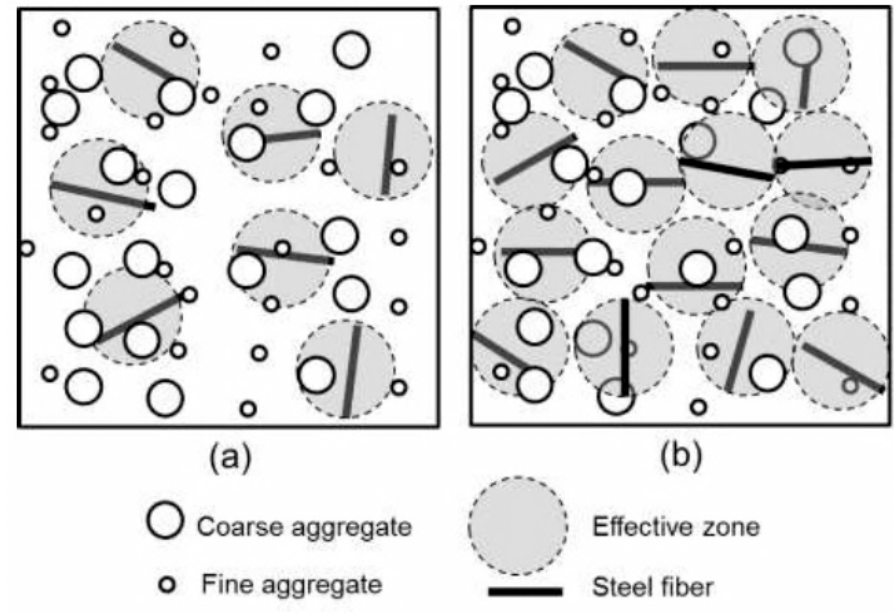
Figure 11. The effect of confinement by steel fibers for ( a ) low fraction and ( b ) high fraction.